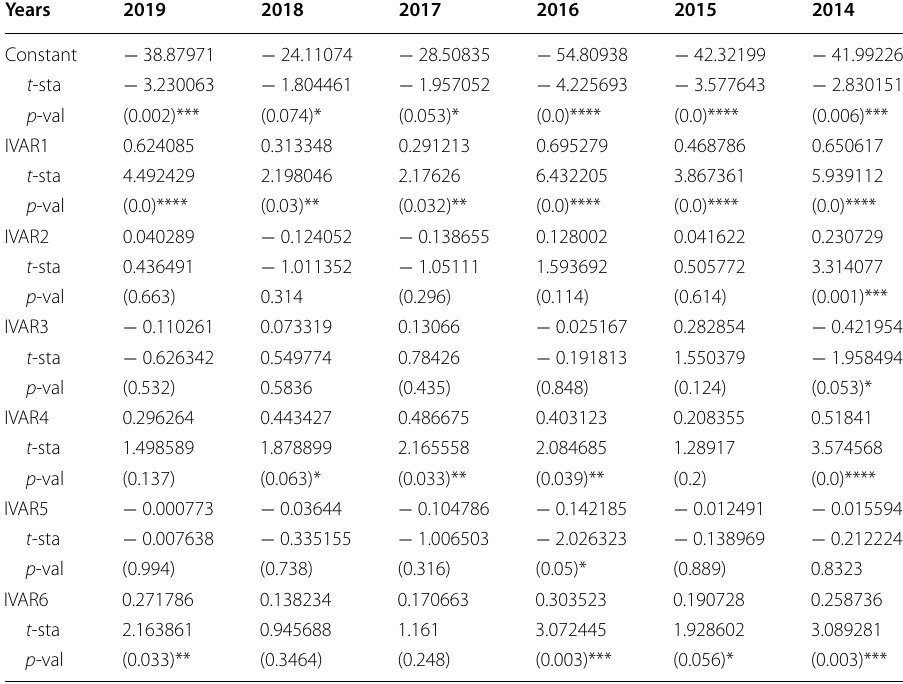
Table 4 Cross-sectional analysis of the Entrepreneurial Aspirations Sub-Index (ASP)